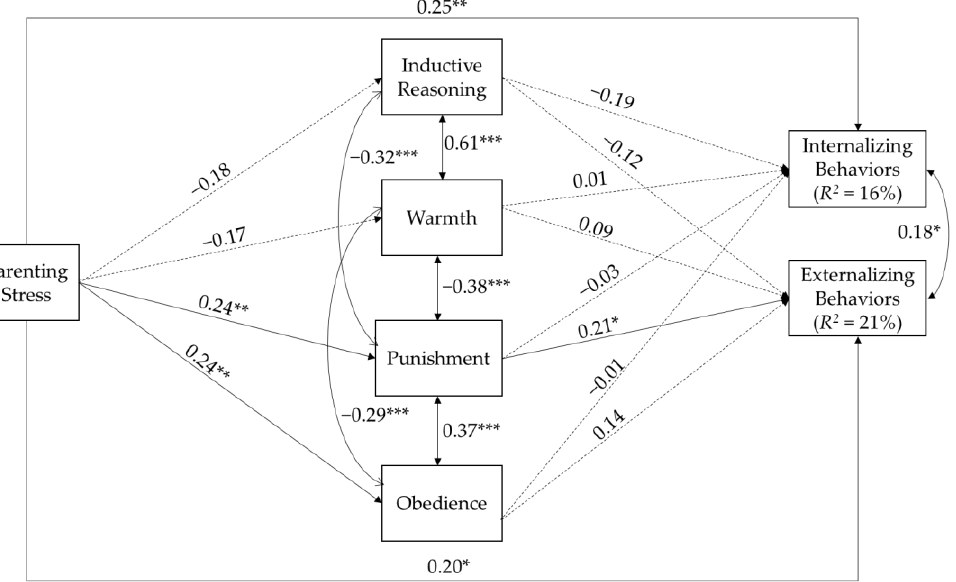
Figure 1. The path model with standardized coefficients. Fathers’ parenting stress predicting children’s internalizing and externalizing behaviors through parenting approaches. Note. Dashed lines represent nonsignificant paths. Child’s age as a covariate was controlled for the internalizing ( β = 0.18, p = 0.01) and externalizing behaviors ( β = − 0.19, p = 0.01). *** p < 0.001, ** p < 0.01, * p < 0.05.